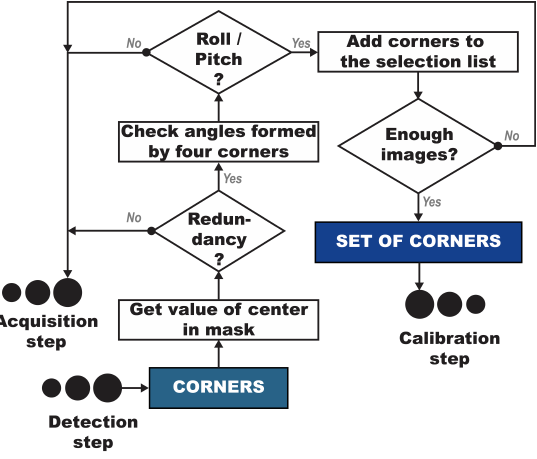
Figure 8. Detailed flowchart of the selection